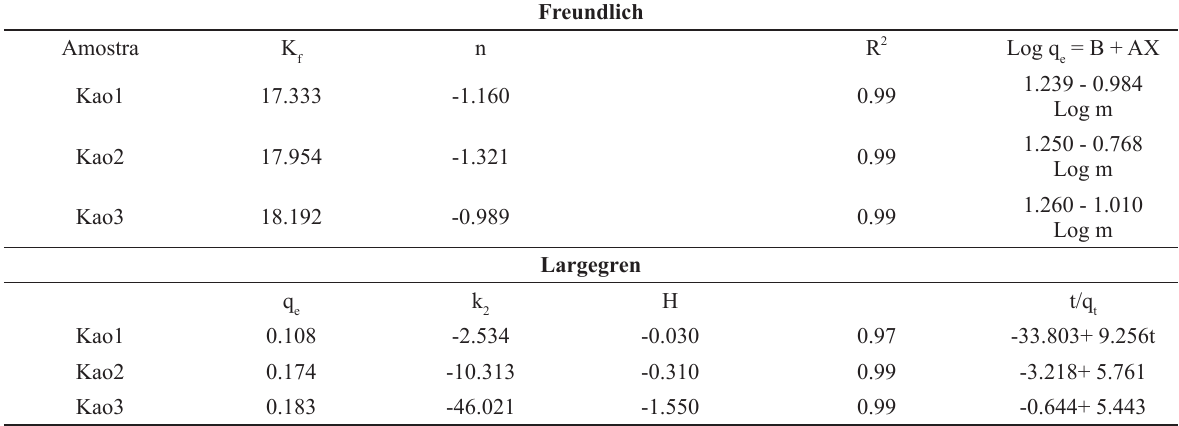
Parameters of Freundlich adsorption kinetics and Largegren (equation